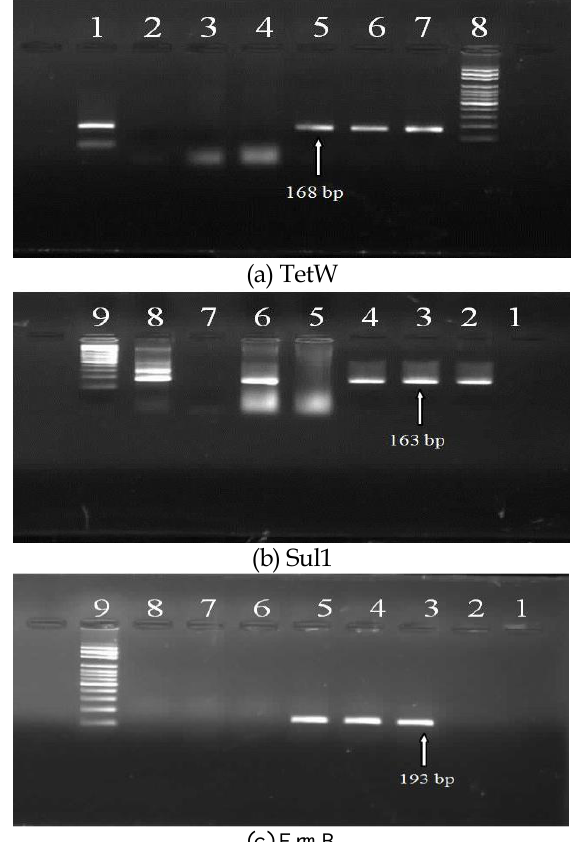
Figure 1. Polymerase chain reaction (PCR) product profiles of TetW (a), Sul1 (b), and ErmB (c) As shown in figure 3, the frequencies of ARGs in influent and effluent are sul1 > ermB